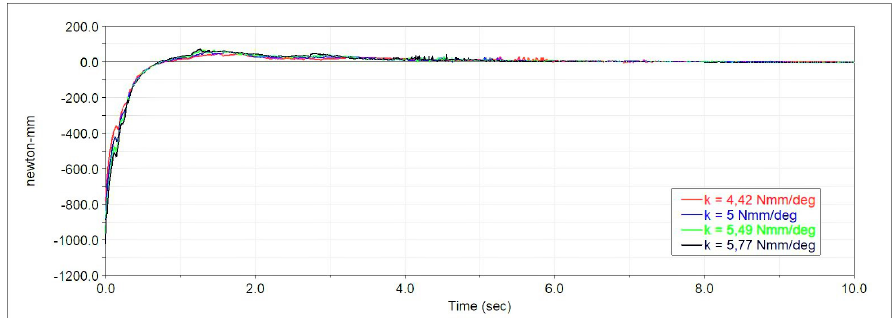
Figure 16. Spring-damper system torque of the first cell as a function of the simulation time and when the stiffness coefficient varies from 4.42 to 5.77 N ·